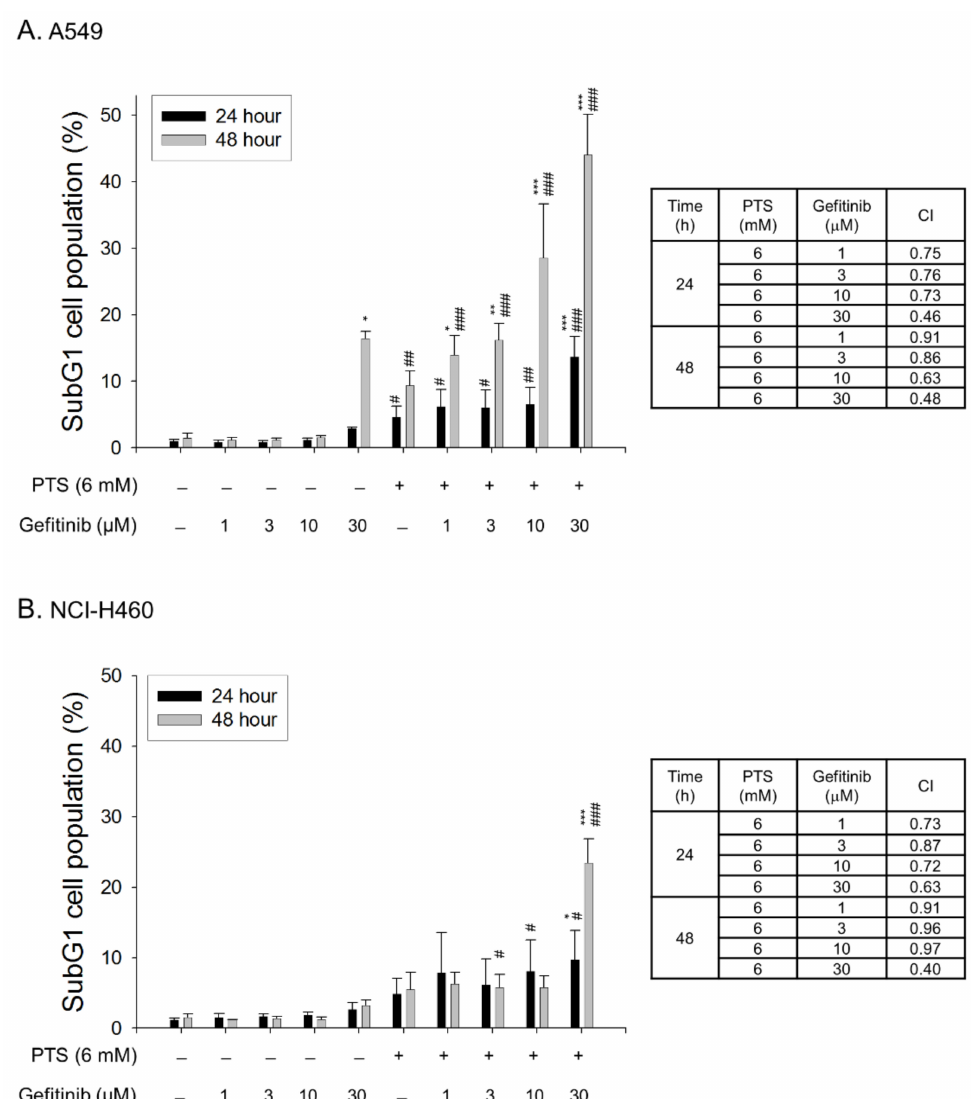
Figure 7. Effect of combination between para -toluenesulfonamide and gefitinib on cell death. A549 ( A ) and NCI-H460 cells ( B ) were treated with or without the indicated agent for 24 or 48 h. Then, the cells were obtained for examining cell population at sub-G1 phase by cytoflowmetry experiment of PI staining. The resulting combination index (CI) values were less than 1.0 confirming the synergistic effects. Quantitative data are expressed as mean ± SEM of three independent experiments. * p < 0.05, ** p < 0.01 and *** p < 0.001 compared with the drug-free control. # p < 0.05, ## p < 0.01 and ### p < 0.001 compared with the respective concentration of